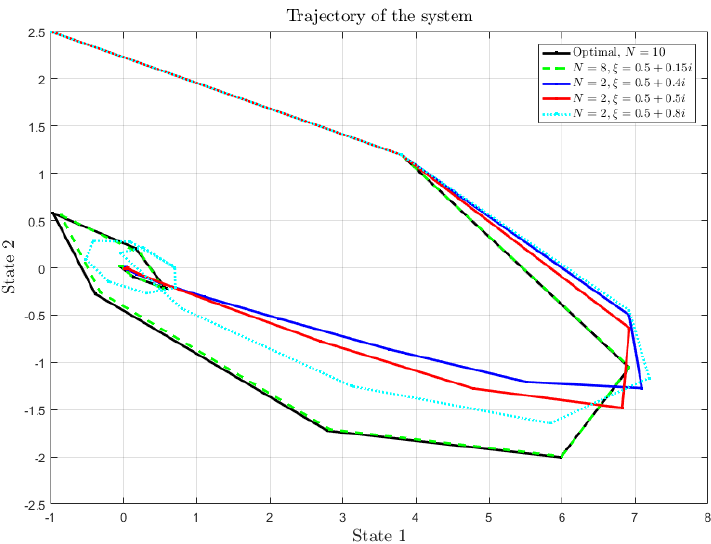
Figure 5. Phase plane trajectory for different Kautz